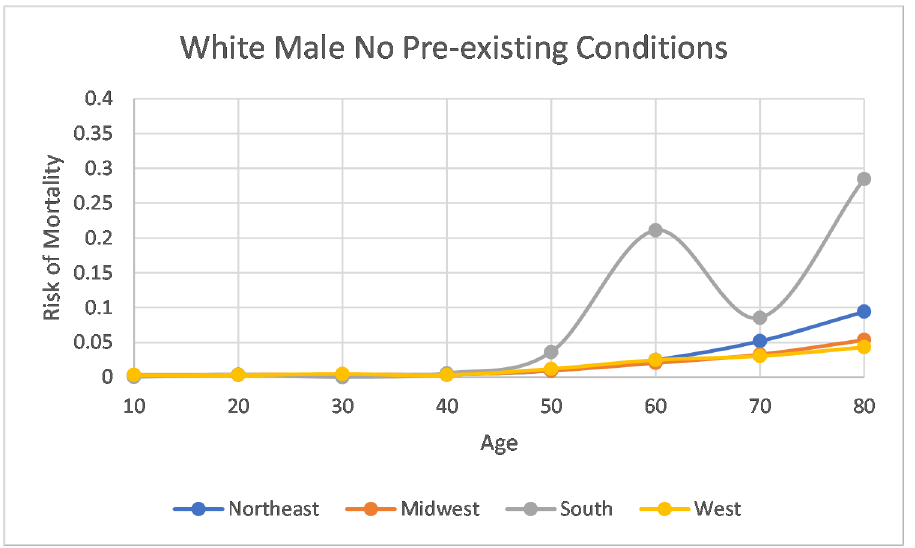
Figure 7. Probability of mortality for a white male with no pre-existing conditions for certain age groups. Given as a decimal. Same information as in Table 8.